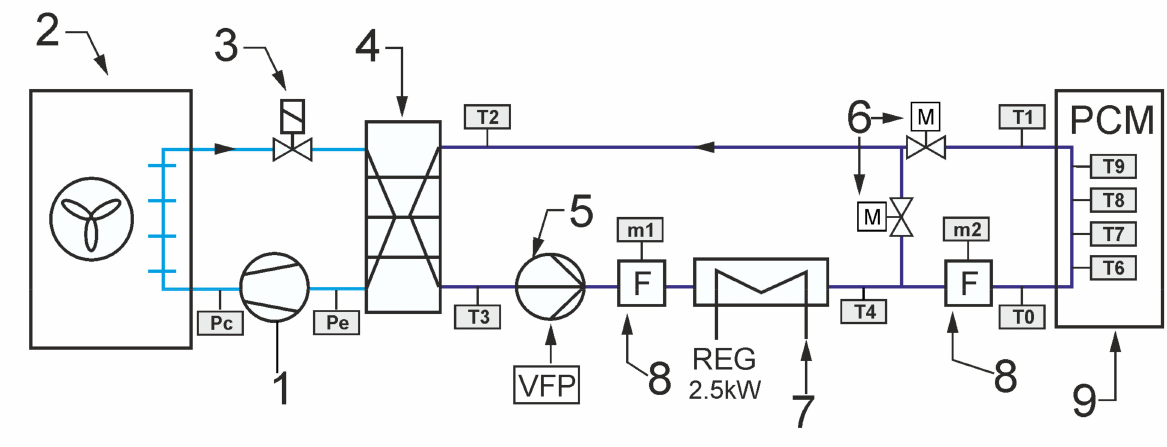
Figure 9. Layout of experimental setup: 1 —compressor, 2 —condenser, 3 —electronic expansion valve, 4 —evaporator, 5 —circulating pump, 6 —control valves, 7 —heater, 8 —flowmeters, 9